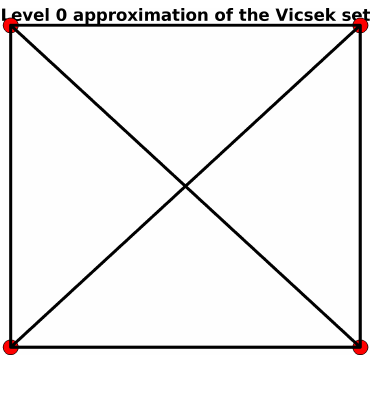
Figure 2: Level 0 approximation.